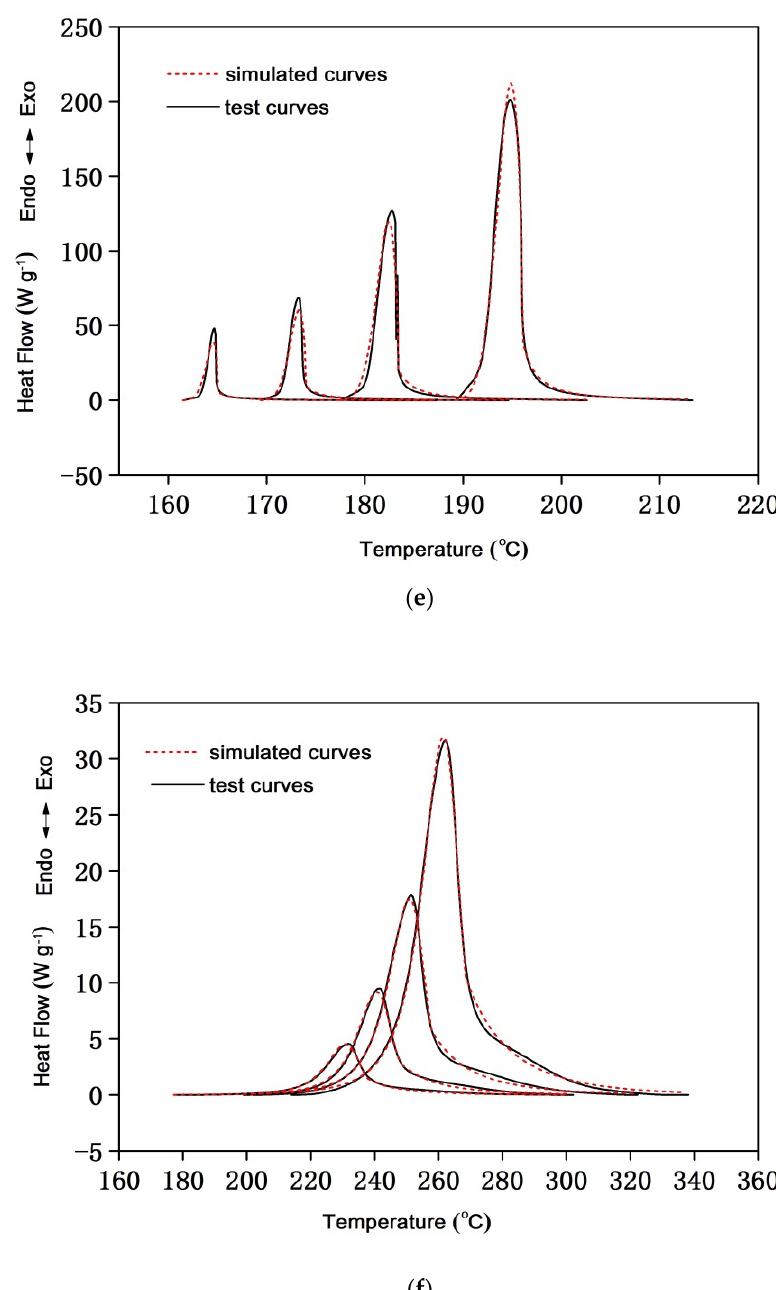
Figure 3. DSC measurements of LLM-116 ( a ) and LLM-226 ( b ) at the heating rates of 2.5, 5, 10 and 20 ◦ C · min − 1 ; TG-DTG curves of LLM-116 ( c ) and LLM-226 ( d ); Simulated and test curves of LLM-116 ( e ) and LLM-226 ( f ).